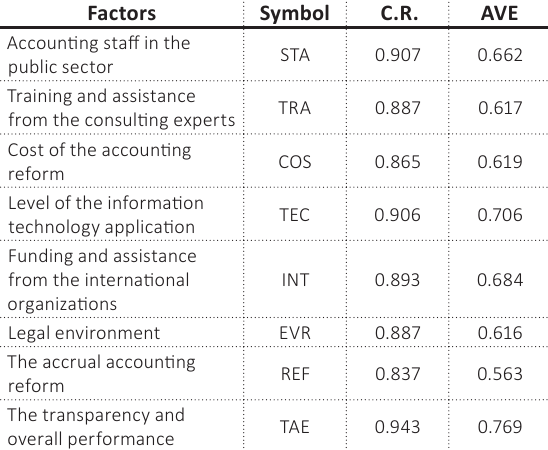
Table 2. Test results of Cronbach’s Alpha